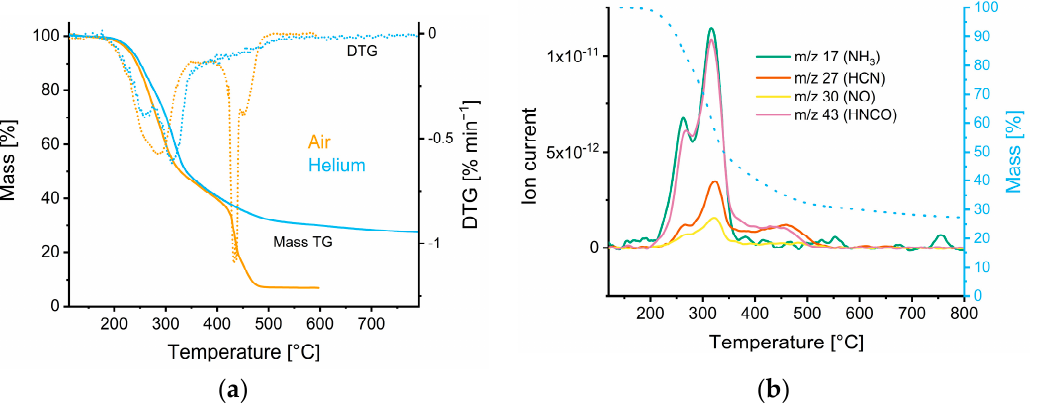
Figure 1. ( a ) TG (straight lines) and DTG (dotted lines) curves of a TG experiment under air as well as inert conditions in helium. ( b ) Evolution of nitrogen containing gases during the pyrolysis under helium of CSS; the dashed line indicates the mass loss of the solid material.